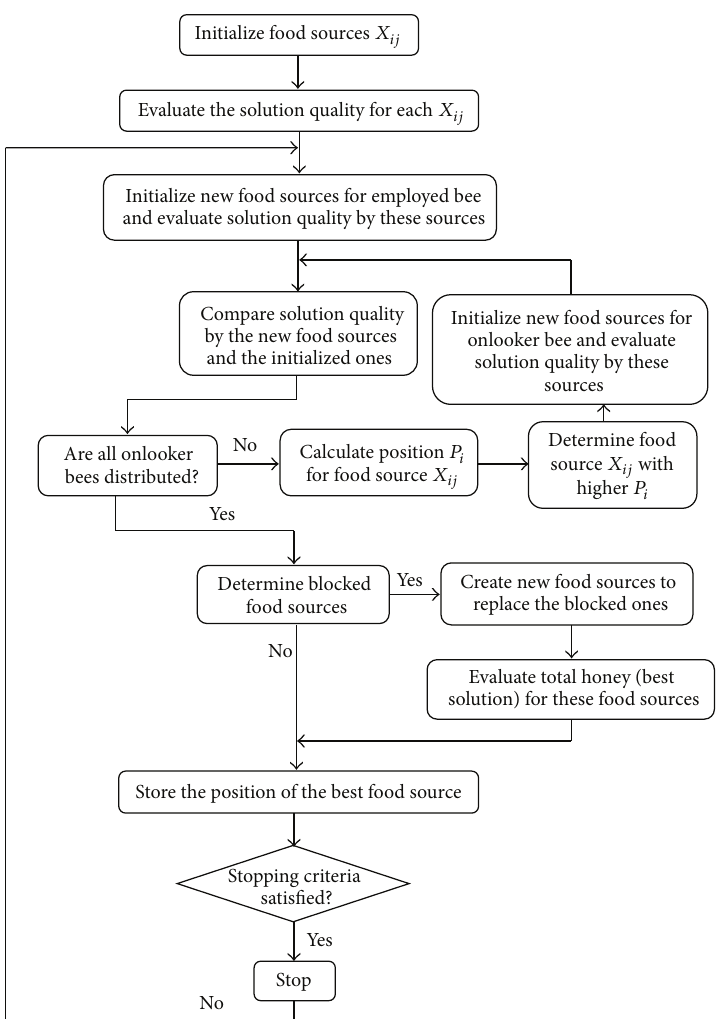
Figure 1: Flowchart of the ABC